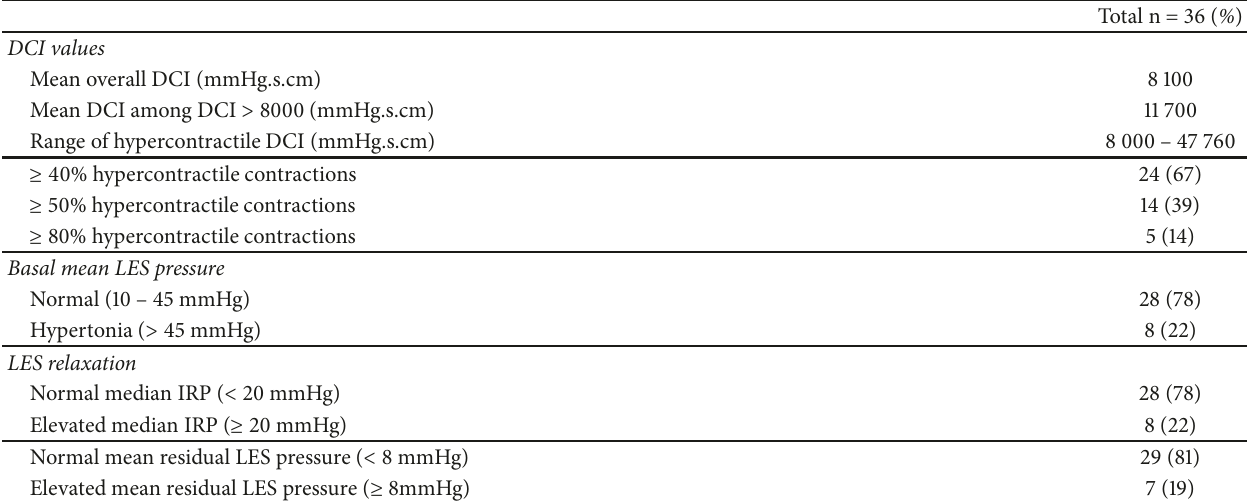
Table 3: Manometric characteristics in patients with Jackhammer esophagus.